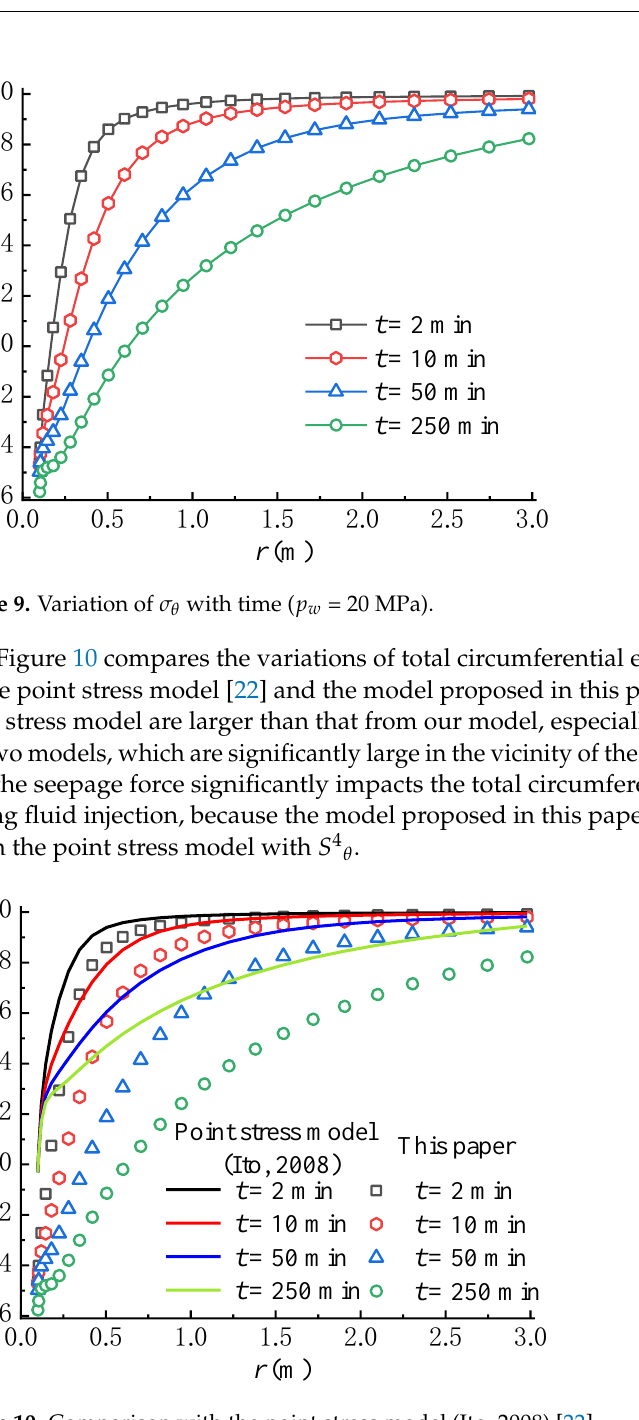
Figure 10. Comparison with the point stress model (Ito, 2008) [22].